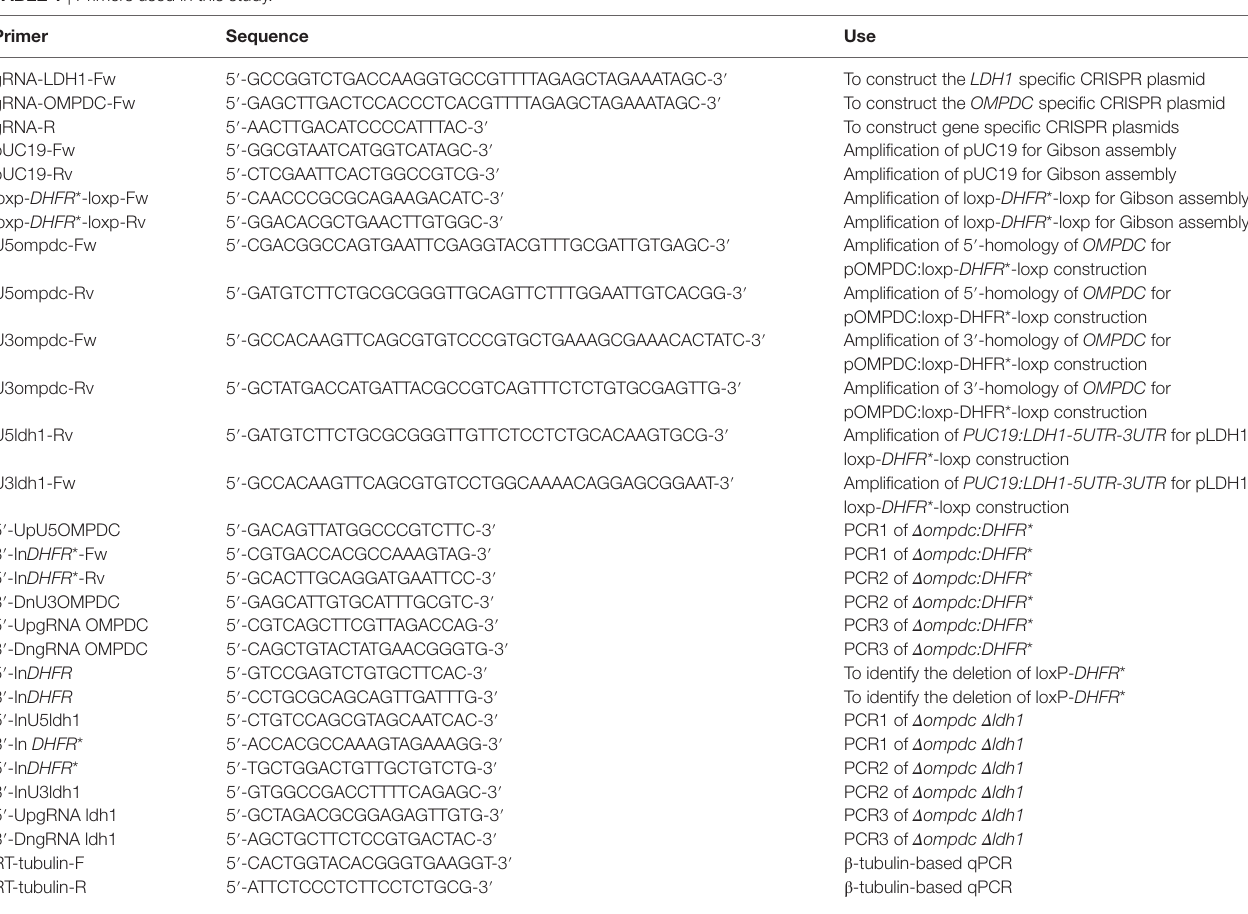
TaBle 1 | Primers used in this